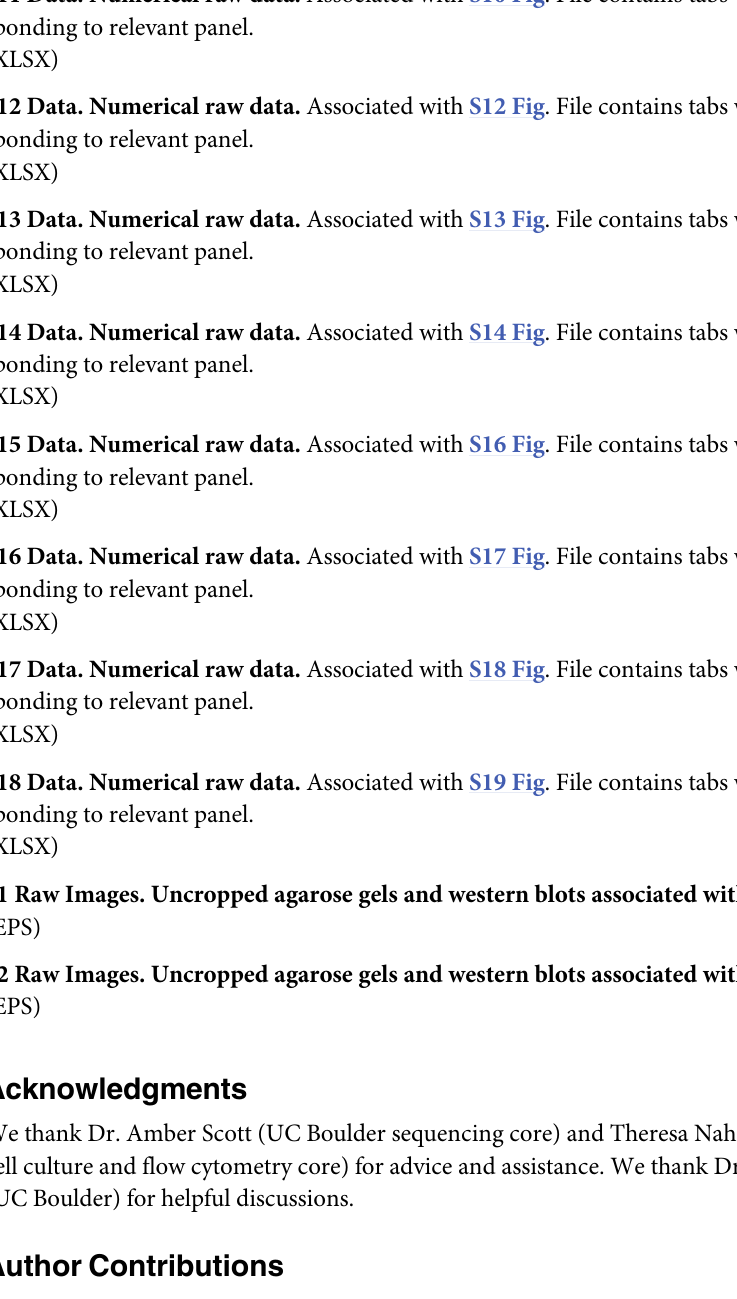
S1 Raw Images. Uncropped agarose gels and western blots associated with S1 Fig. S2 Raw Images. Uncropped agarose gels and western blots associated with S19